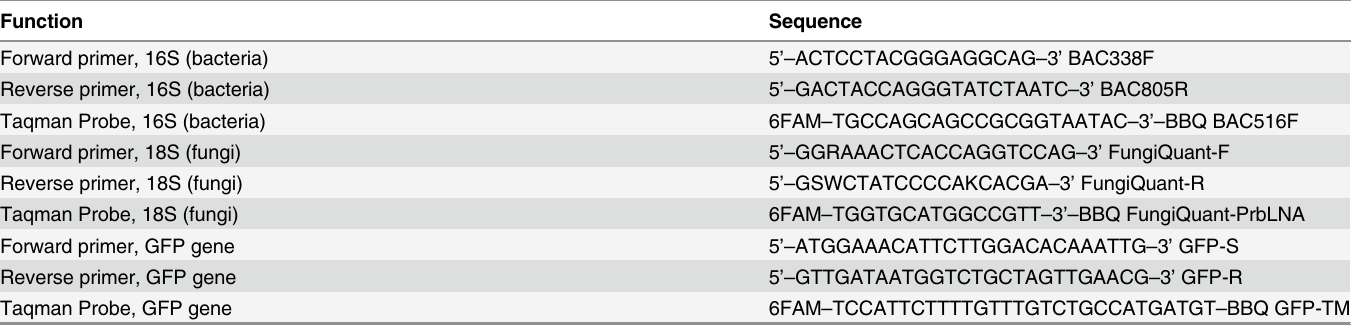
Table 1. Probe-and-primer sets for qPCR assays.